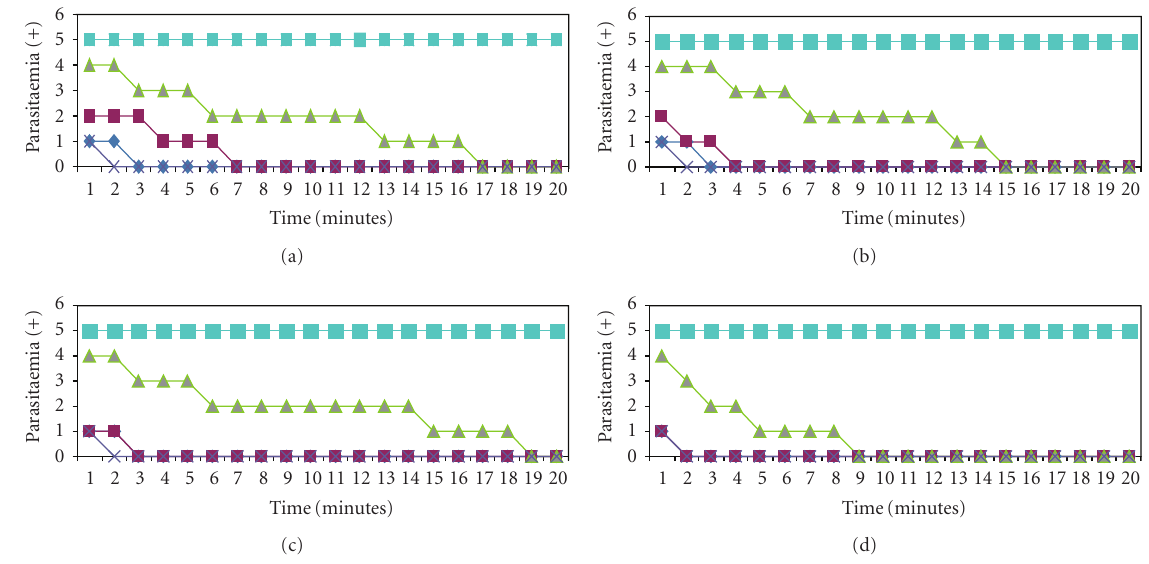
Figure 1: E ff ect of CS (a), ED (b), EC, (c) and CC (d) essential oils (EO) on T. evansi blood forms. The EOs were diluted at 0.4 g/mL (dark blue), 0.2 g/mL (red) and 0.1g/mL (green) in pure vegetable oil as diluent and then added to the cultures, as described previously. Treatment of the parasites with Diminaveto (Positive control, purple) induced total lysis after 2 minutes. The number of parasites remained constant in negative controls and diluent control (light blue).